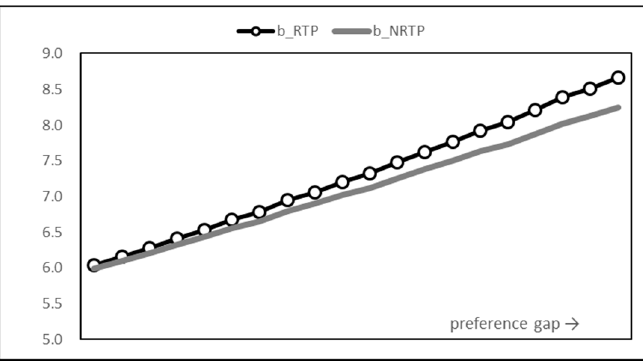
Energies 2020 , 13 , x FOR PEER REVIEW